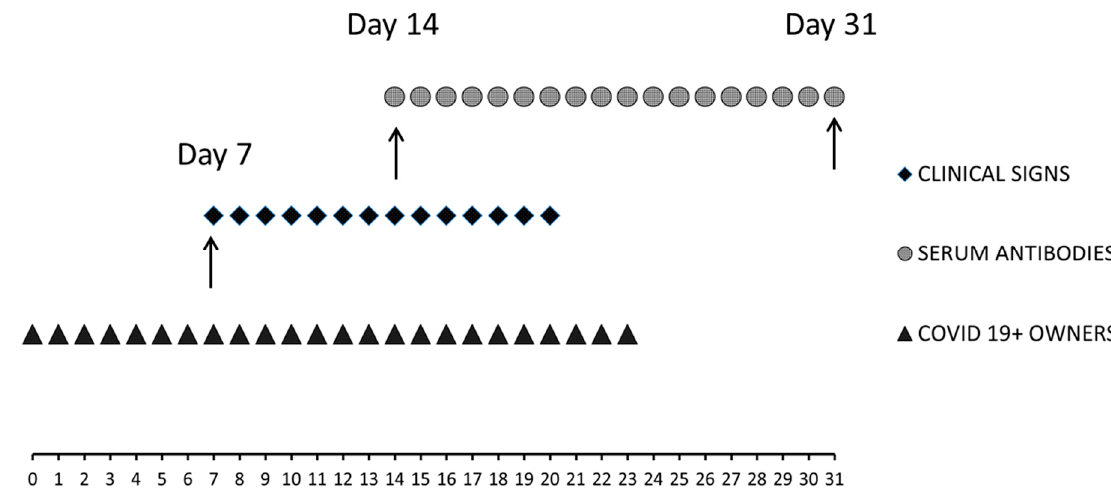
Figure 1. Schematic representation of the clinical case events. The cat started presenting respiratory and gastrointestinal signs on Day 7. On Day 14 occurred the first veterinary examination (sample setting and thoracic radiographies) and the beginning of medical treatment administration. On Day 21, the cat no longer presented clinical symptoms. On Day 31, the second veterinary consult (sample setting and chest radiographies) was carried out. Specific serum antibodies were detected starting from Day 14 (ELISA, ECLIA and PRNT).